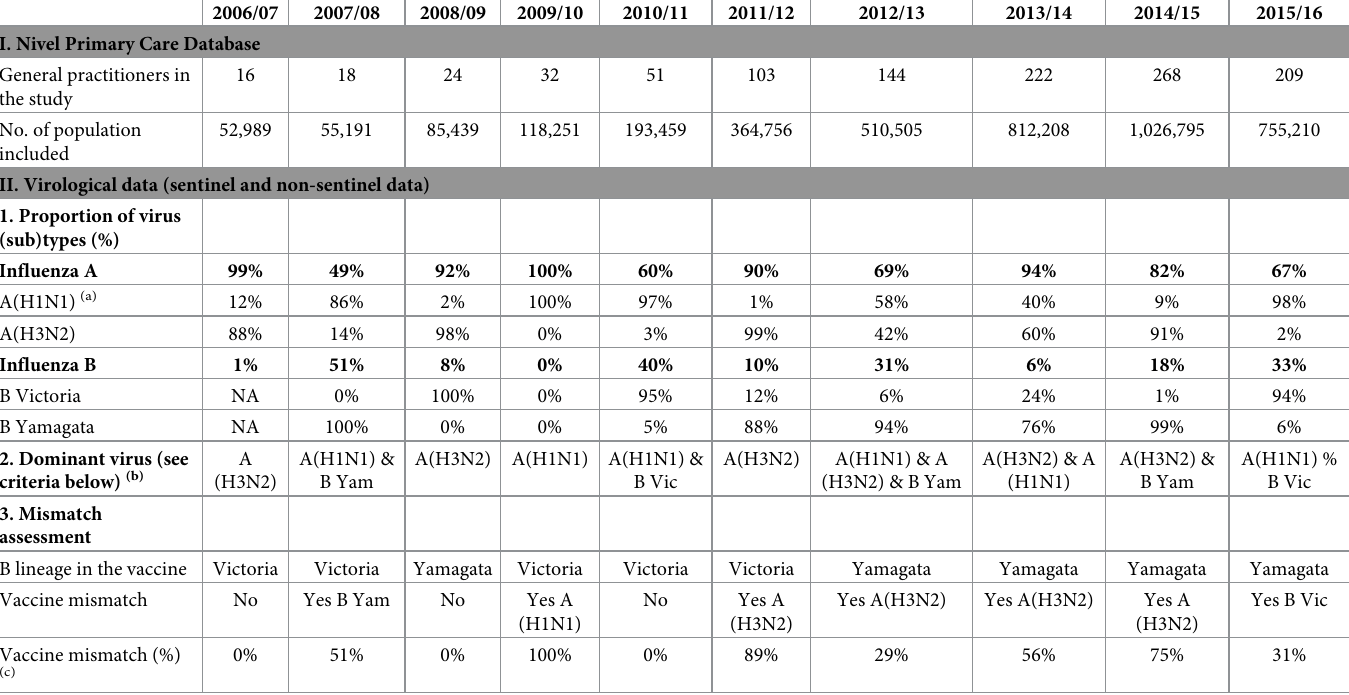
Table 1. Number of general practitioners, population studied, and background virological information (circulating influenza viruses and vaccine mismatch) in each season. Netherlands, 2006/07 to